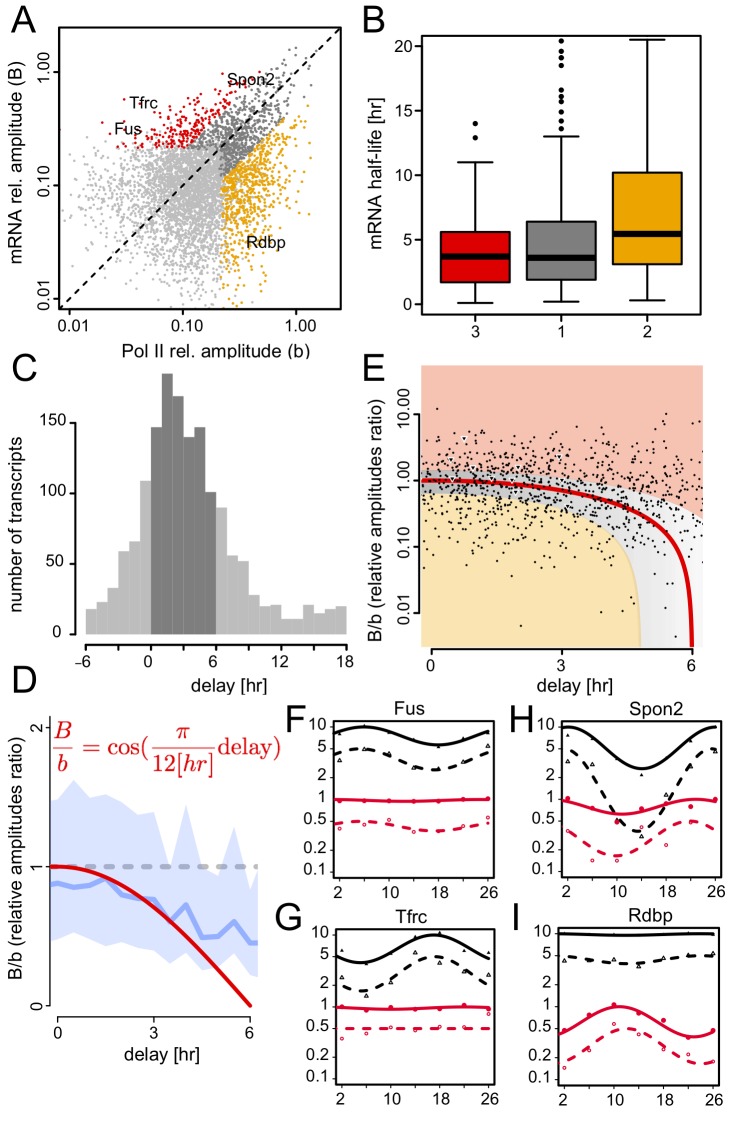
Amplitude and phase relationships between Pol II signals and mRNA accumulation identify posttranscriptional regulation in mRNA accumulation.(A) Relative amplitudes (maximum minus minimum, divided by twice the mean after background subtraction; see Materials and Methods) of oscillations in Pol II promoter signals and mRNA accumulation identify rhythmic mRNAs with relative amplitudes comparable to that of transcription (class 1, gray, 675 genes), long-lived transcripts with damped mRNA rhythms (class 2, orange, 668 genes), and mRNAs where posttranscriptional regulation increases rhythmic amplitude (class 3, red, 217 genes). Light gray genes are all genes that cycle robustly in either Pol II or mRNA accumulation (3,446 genes). Fus, Tfrc, and Spon2 are representative of class 3 and Rdbp of class 2 (see panels F–I for qRT-PCR validations). The few values larger than 1 are due to low signals when background subtraction makes trough values negative. (B) Half-lives of the three classes taken from NIH-3T3 fibroblasts [46] show a significant difference (TukeyHSD p value <10−6 for class 2 versus class 1, and class 2 versus class 3). (C) Delays in peak mRNA accumulation versus peak Pol II promoter loading for the union of class 1, class 2, and class 3 genes. The dark gray region delimits the range predicted for a model with constant half-lives (0 h delay for very short-lived up to 6 h for very long-lived transcripts). (D–E) For the same genes the ratio of relative amplitudes (B = relative amplitude of Pol II, b = relative amplitude of mRNA) is plotted against the phase delay, together with the prediction for a constant half-life (red line). The trend (in D, median is the blue line and 25% and 75% percentiles are shown as light blue shading) shows that the ratio is centered on one at short delays and decreases for larger delays. The scatter plot (E) highlights genes for which transcript accumulation is explained by a constant half-life (dark gray area represents short and light gray long half-lives), and genes where nonconstant half-lives either suppress (light orange) or enhance (light red) amplitudes in mRNA accumulation. Triangles show core circadian clock genes. (F–I) Transcription and mRNA accumulation for representative genes. Comparison of (i) mRNA levels as measured by gene expression arrays, (ii) promoter Pol II occupancy as measured by ChIP-Seq, and (iii) pre-mRNA and (iv) mRNA levels as measured by qRT-PCR with intronic and exonic probes, respectively. Symbols and lines indicate measurements and cosine fits, respectively. Open symbols and dashed lines show qRT-PCR data (cDNA from n = 4 animals where pooled) with circles for the pre-mRNA and triangles for the mRNA. Continuous lines and filled symbols represent Pol II ChIP-seq (circles) and mRNA Affymetrix data (triangles). Each temporal profile has been scaled to an arbitrary mean for visualization. Pre-mRNA levels closely follow Pol II promoter occupancy, as expected (given the short half-lives of pre-mRNAs). Fus and Spon2 (F and H) show higher amplitude in mRNA compared to transcription; Tfrc (G) is transcribed at similar rates around the clock but shows rhythmic mRNA accumulation; Rdbp (I) shows rhythmic transcription but dampened mRNA accumulation.